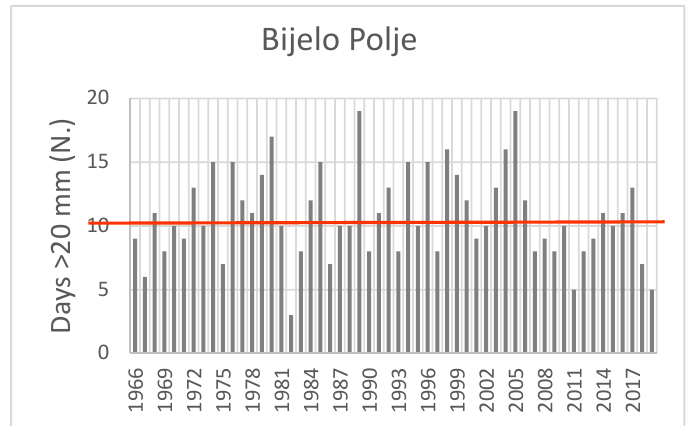
Figure 5. Time series of the number of days with rainfall higher than 20 mm in a year. The red line discriminates the years with more than ten days with a daily intensity of 20 mm or more.